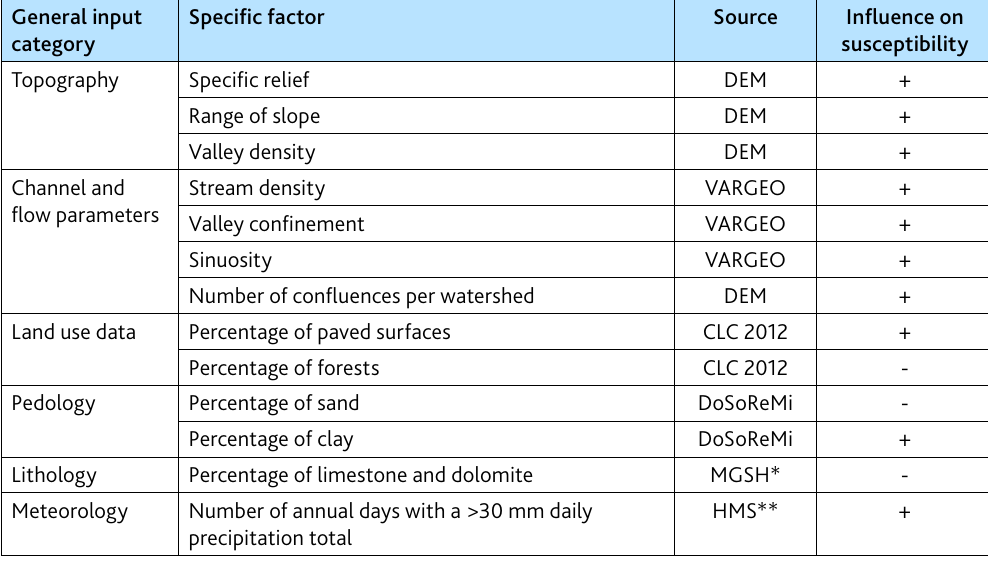
Table 1. Watershed scale input parameters for the